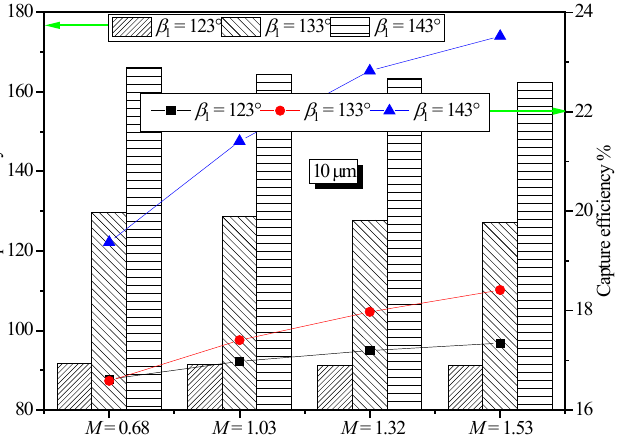
Figure 10. Variation of impact efficiency and capture efficiency with different inlet angles at four blowing ratios, d p = 10 μm.